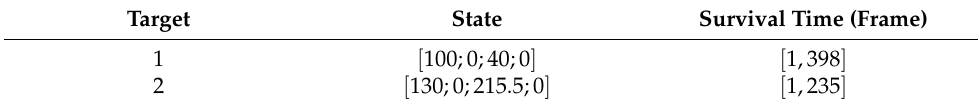
Table 4. Average computational times.